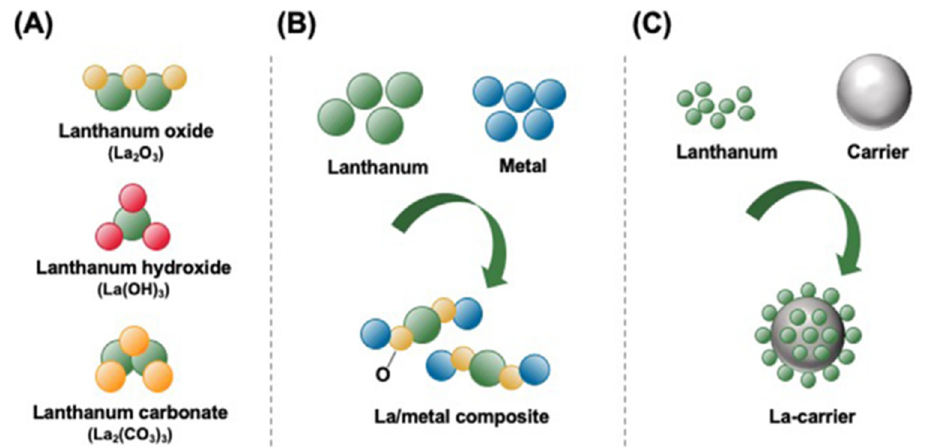
Figure 12. Schematic diagram of the structures of different types of La-based adsorbents: ( A ) single La compounds; ( B ) La-metal composites; ( C ) “La-carrier” absorbents [61].